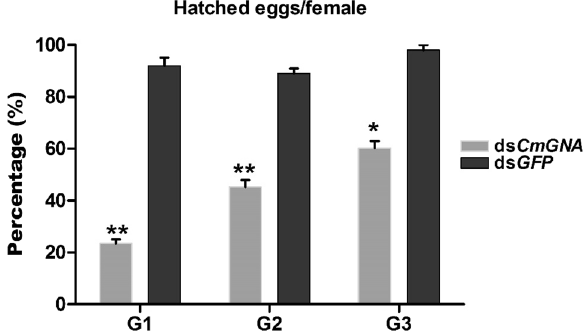
Figure 2. The percentage of hatched eggs per female were observed in G1–G3 generations. Each point indicates the mean ± standard error in G1–G3 generations and their control groups. Significant differences indicated by *(P < 0.05), **(P < 0.01).